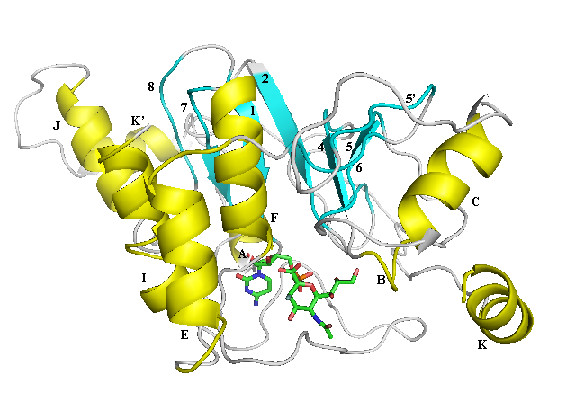
Cartoon diagram of human ST3Gal I modeled using the structure of CstII (PDB id 1RO7). Helices (A, B, C, E, F, I, J, K and K'; in yellow) and strands (β1, β2, β4, β5, β5', β6, β7 and β8; in cyan) have been given the same names as those of corresponding helices and strands in CstII. Residues constituting these helices and strands are given in Figure 1. The location of CMP-3-fluoro-NeuNAc (stick representation; carbon, green; oxygen, red; nitrogen, blue) has been derived by superposition of the modeled structure on that of the CstII- CMP-3-fluoro-NeuNAc complex. The structure was rendered using PyMol.